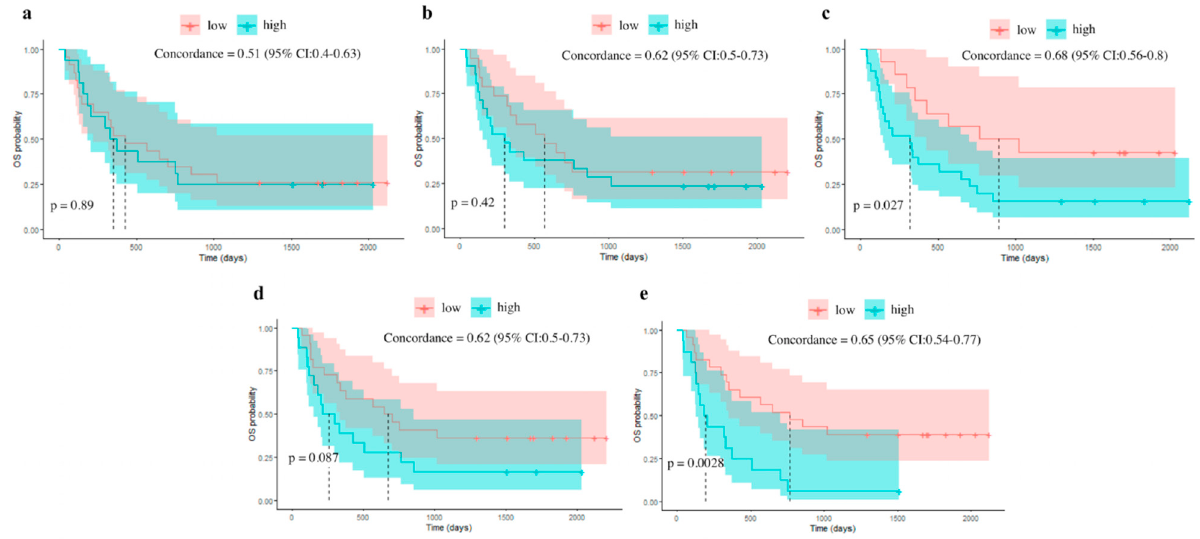
Figure 4. External dataset OS Kaplan–Meier curves with split based on Cox proportional hazard for the clinical model ( a ); the radiomics single-lesion model ( b ); the delta-radiomics model ( c ); the com- bined radiomics single-lesion model ( d ); and the combined delta-radiomics model ( e ).